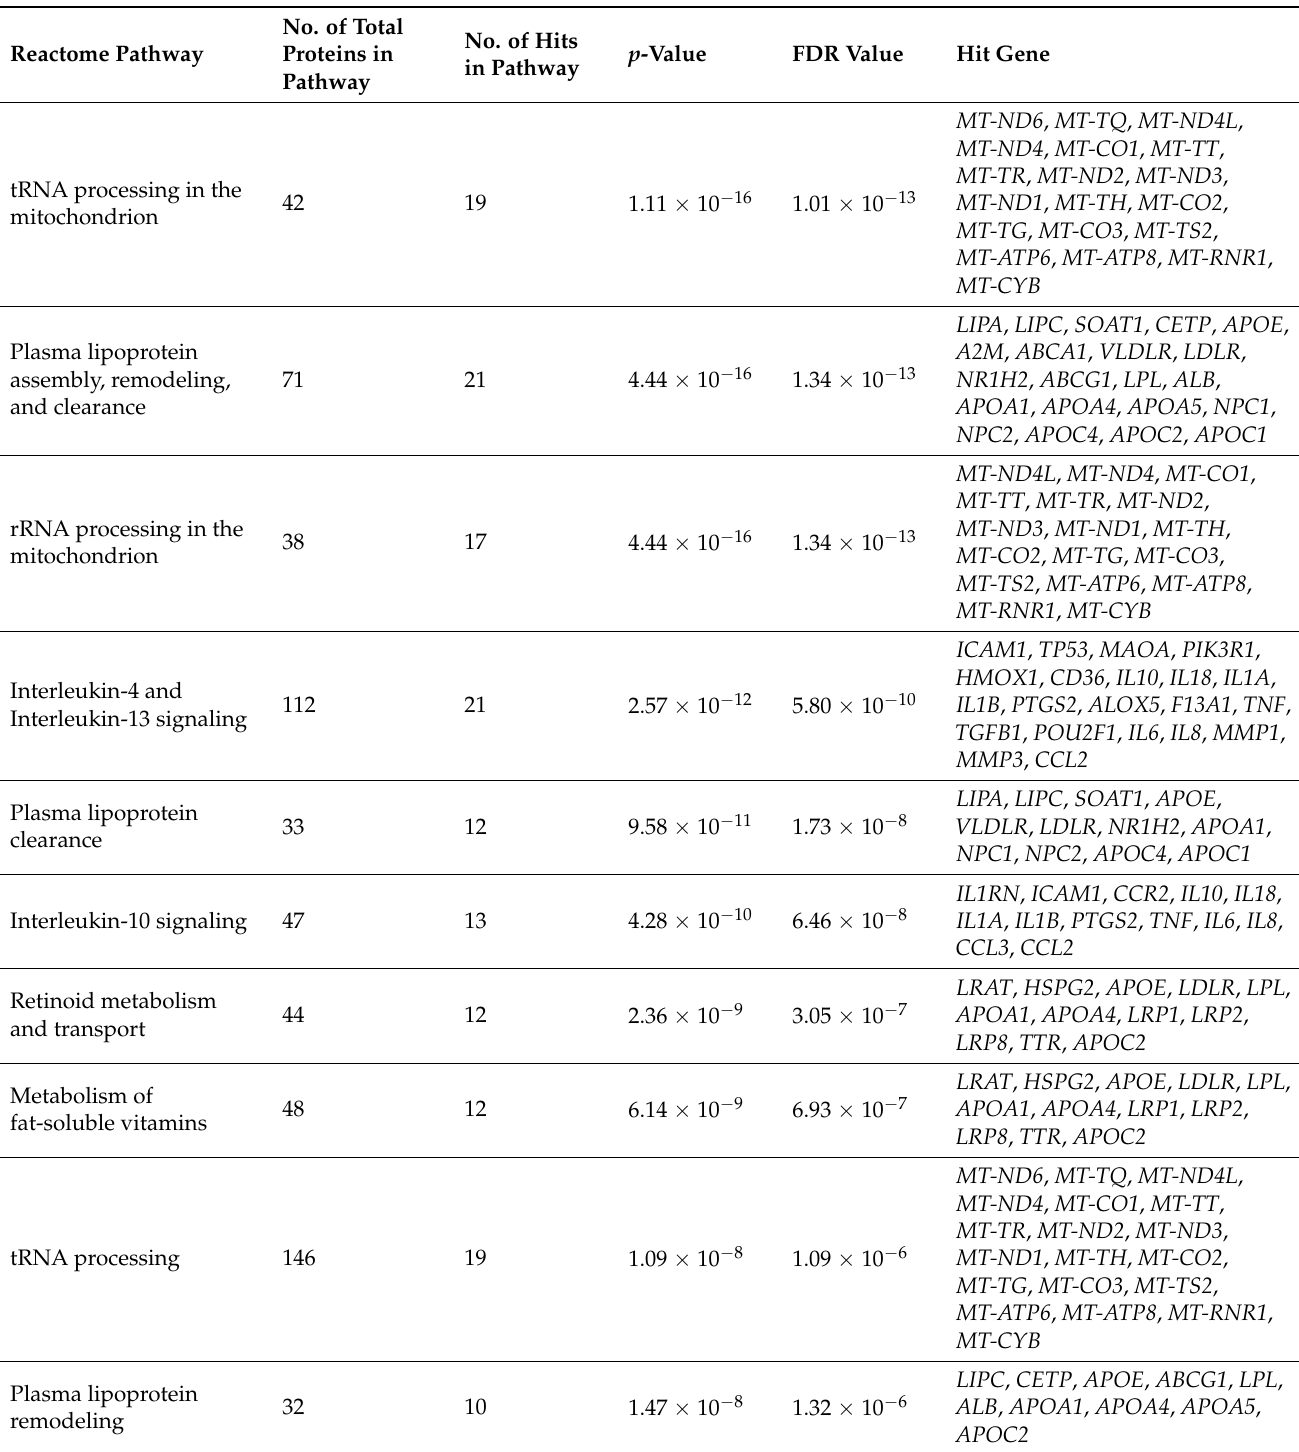
Table 1. Reactome pathway enrichment analysis results—Positive AlzGene (AD)